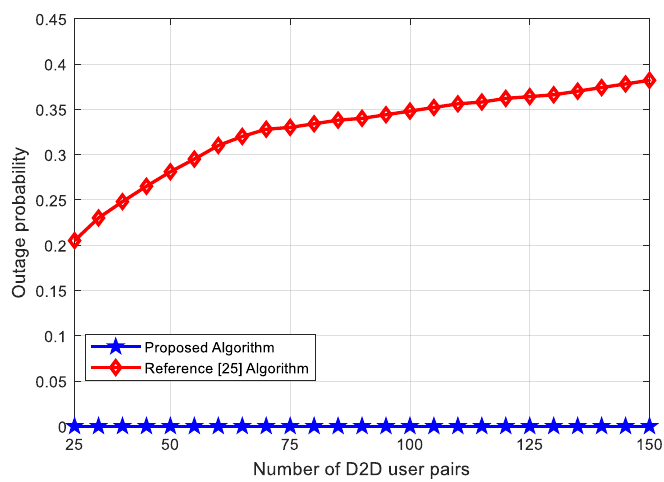
Figure 3. Comparison of the outage probability of the proposed algorithm and existing algorithms under a different number of device-to-device (D2D) users.